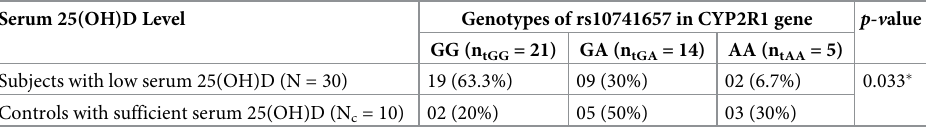
Controls with sufficient serum 25(OH)D (N c = 10) 02 (20%) Freeman-Halton extension of Fisher’s exact test was done to analyze data; N t = Total number of subjects; N = Total number of study population; N c = Total number of controls; n tGG = Total number of genotype GG in study subjects; n tGA = Total number of genotype GA in study subjects; n tAA = Total number of genotype AA in study subjects; Figure in parenthesis shows percentage; The test of significance was calculated for all comparisons and p value < 0.05